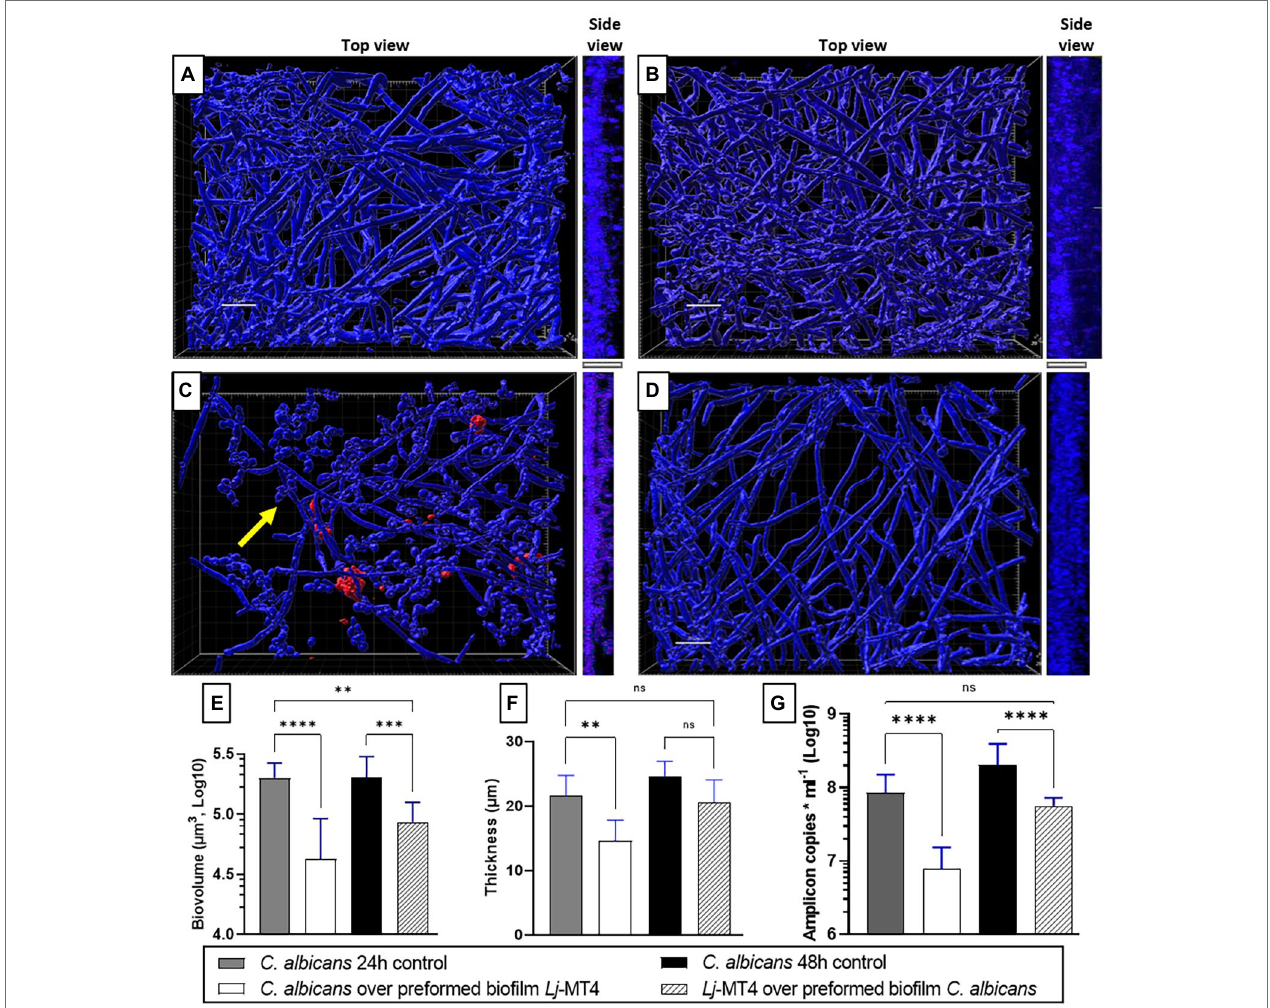
FIGURE 9 | Lactobacillus johnsonii displays exclusion and displacement effects against C. albicans biofilms. (A) 24 h-old and (B) 48 h-old single C. albicans biofilms; (C) Addition of C. albicans on preformed L. johnsonii biofilm; (D) Addition of L. johnsonii over preformed C. albicans biofilm; Fungal biofilm (E) biovolumes, (F) thickness, and (G) biomass are significantly reduced in the presence of lactobacilli. Yellow arrows indicate the presence of yeast cells. White bar = 20 nm. One- Way ANOVA, Dunnett posttest. * p ≤ 0.05, ** p ≤ 0.01, *** p ≤ 0.005, **** p ≤